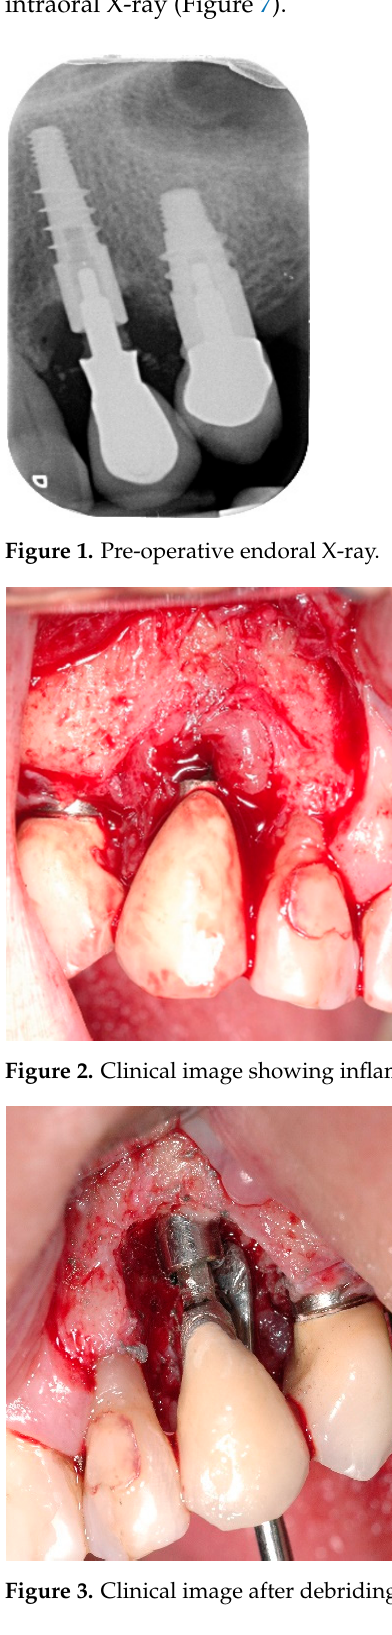
Figure 4. HYBENX ® treatment . ( a ) ( b ) Figure 5. ( a ) Clinical image immediately after decontamination. ( b ) Repositioning of the mucoperiosteal flap.